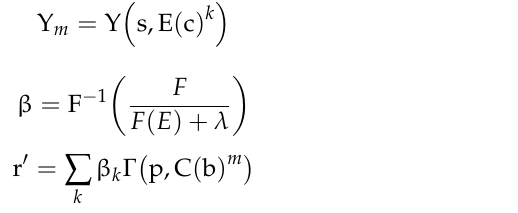
(17) Algorithm 1 The proposed SKCF ship tracker Input : Ship images and ship position in the first frame. Output : Estimated ship tracking position in current frame; if the initial ship frame then 1. Performs parameter initialization; 2. Extracts pre-trained ship patterns and labels; 3. Trains the ship tracker in Fourier domain;